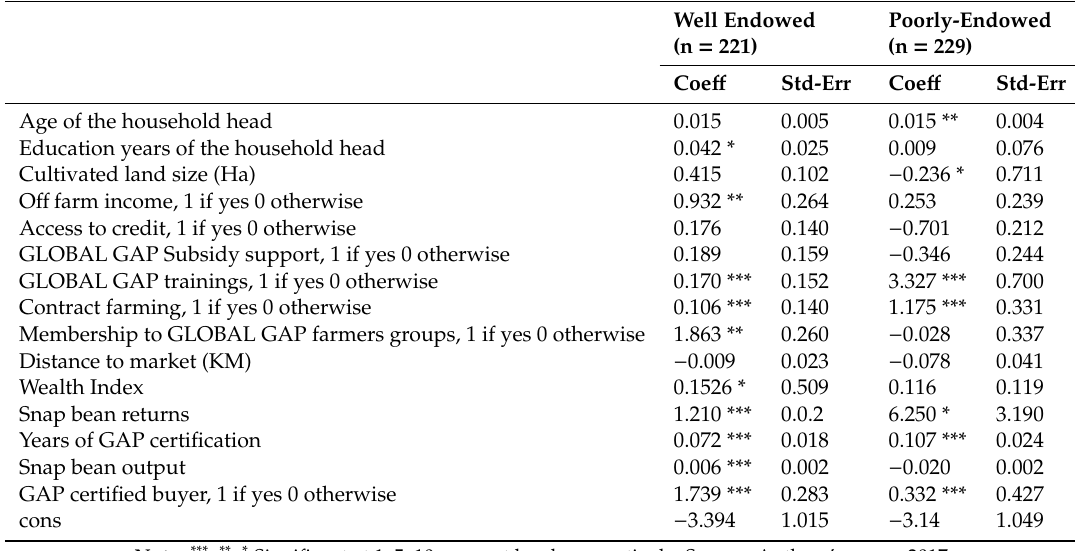
Table 4. Hurdle I: Probability of Adopting